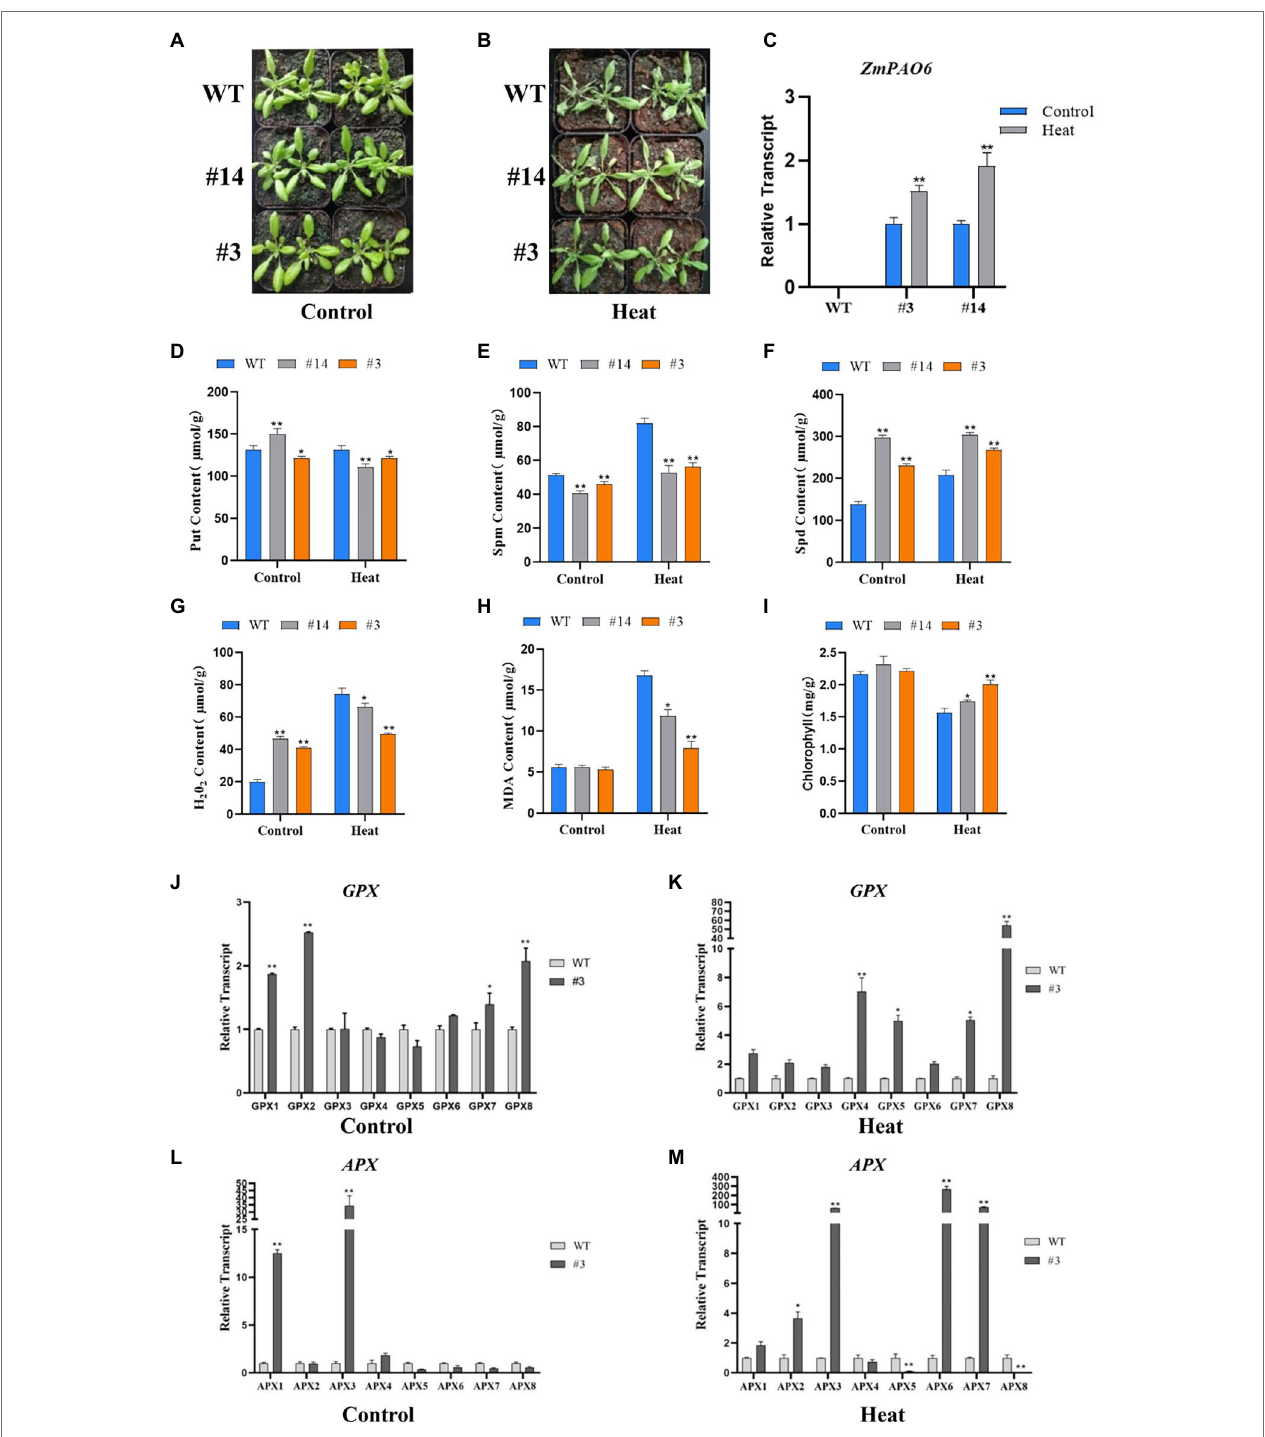
FIGURE 11 | Overexpression of ZmPAO6 gene enhances heat tolerance in Arabidopsis . (A,B) The growth status of WT Arabidopsis and transgenic lines during heat stress treatment. (C) Expression profiles of ZmPAO6 gene in WT Arabidopsis and the transgenic lines under control and heat stress treatment. (D–F) Analysis of Put, Spm and Spd contents in WT Arabidopsis and the transgenic lines under control and heat stress treatment. (G–I) The change of H 2 O 2 , MDA, and Chlorophyll contents in seedlings leaves. (J–M) The expression levels of AtGPX1-8 and AtAPX1-8 under control and heat stress treatment. Error bars are caused by three biological replicates. Asterisks above the error bars represent statistical significance using one-way ANOVA and a Fisher’s LSD. * Significantly different at p < 0.05; ** significantly different at p <